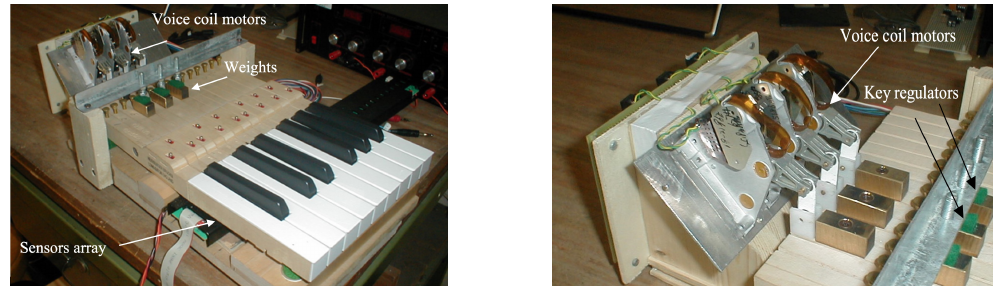
Figure 8. The Multi-Instrument active KEYboard (MIKEY) with a force feedback to the touch.